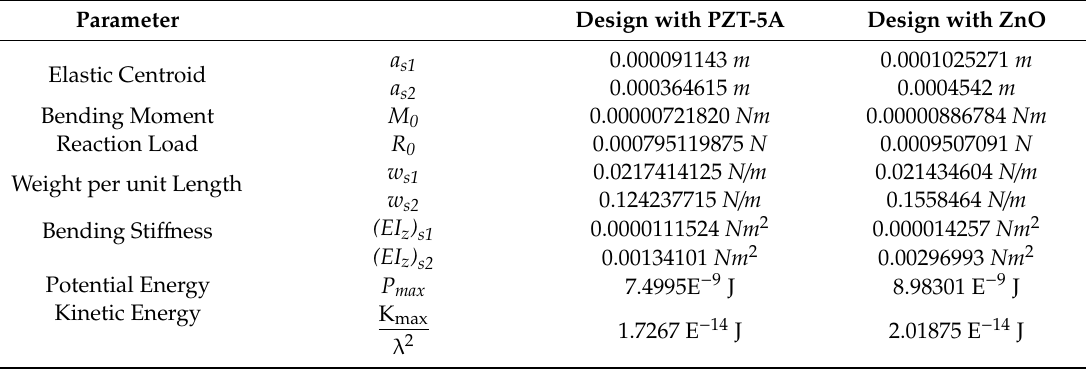
Table 3. Values of the parameters of both PEH devices obtained with the proposed analytical